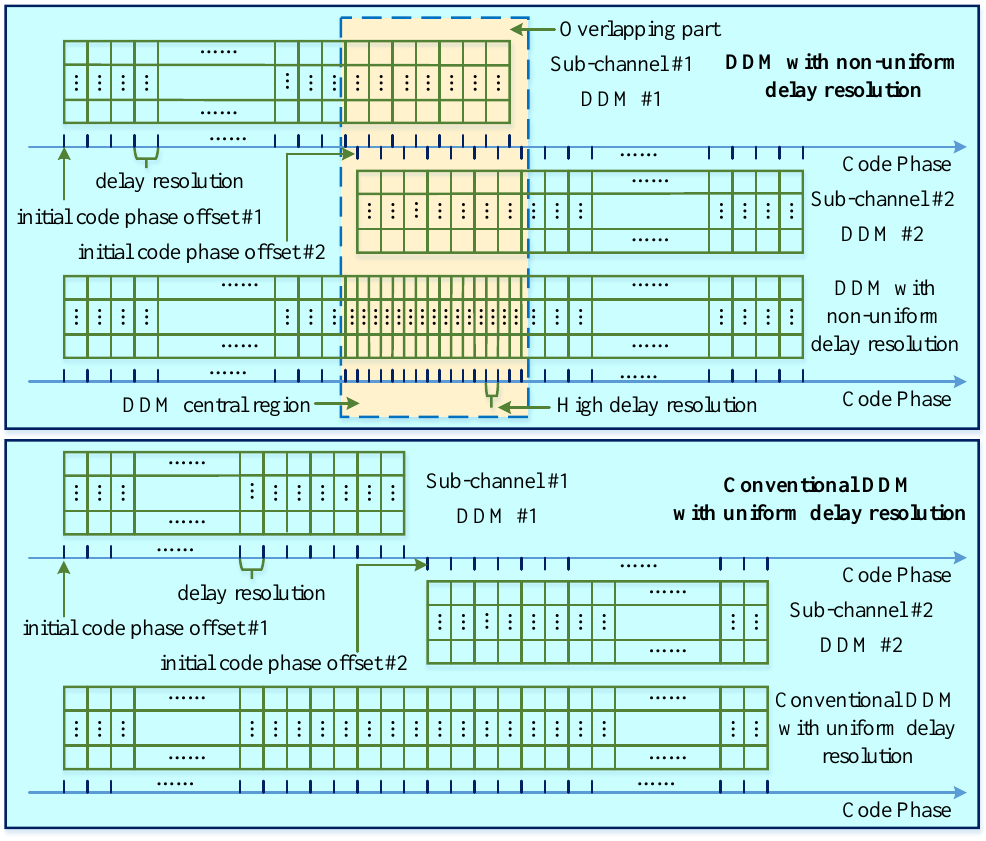
Figure 6. Final output DDM of the GNSS-R module in the SIGRS. The top module shows the generation of the DDM with non-uniform delay resolution. The bottom module shows the generation of the conventional DDM with uniform delay resolution. Table 2. Based on a typical DDM delay scope of − 12.25–12.125 chips, the comparison of number of delay bins between DDM with non-uniform delay resolution and conventional DDM with uniform delay resolution is